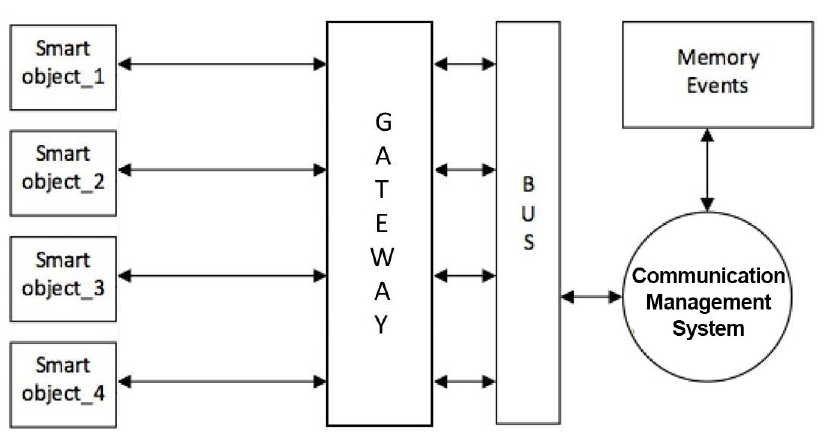
Figure 4. Block diagram of communication interfaces towards SOs (ref. Figure 2, Home assisted).